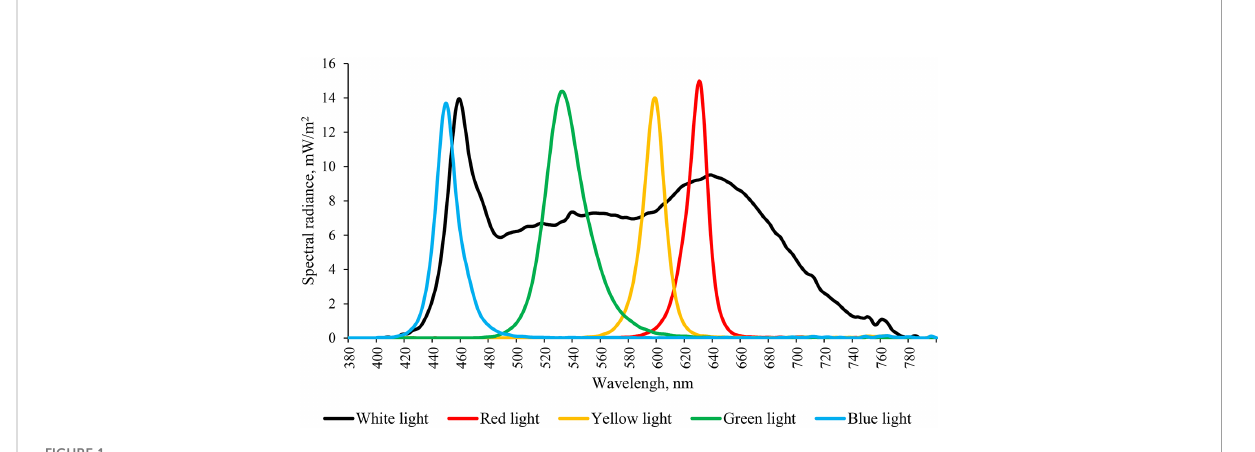
FIGURE 1 Spectral curves of the LED lights ’ spectral compositions in the